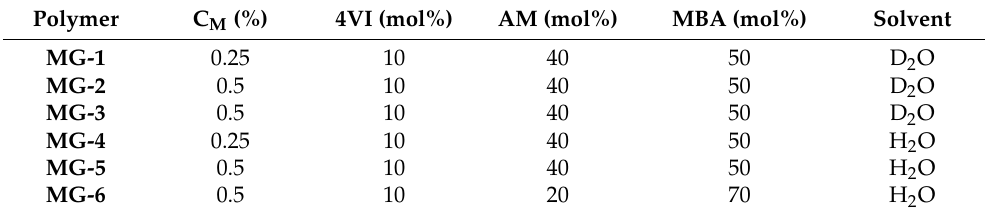
Table 1. Microgels (MGs) composition synthesized using 4-vinylimidazole (4VI), acrylamide (AM), and N,N (cid:48) -methylenebisacrylamide (MBA), and 10% w/w ammonium persulfate (based on the total moles of double bonds) in deuterated water (D 2 O) or de-ionized water (H 2 O) at 70 ◦ C or for 24 h. Polymer C M (%) 4VI (mol%) MBA